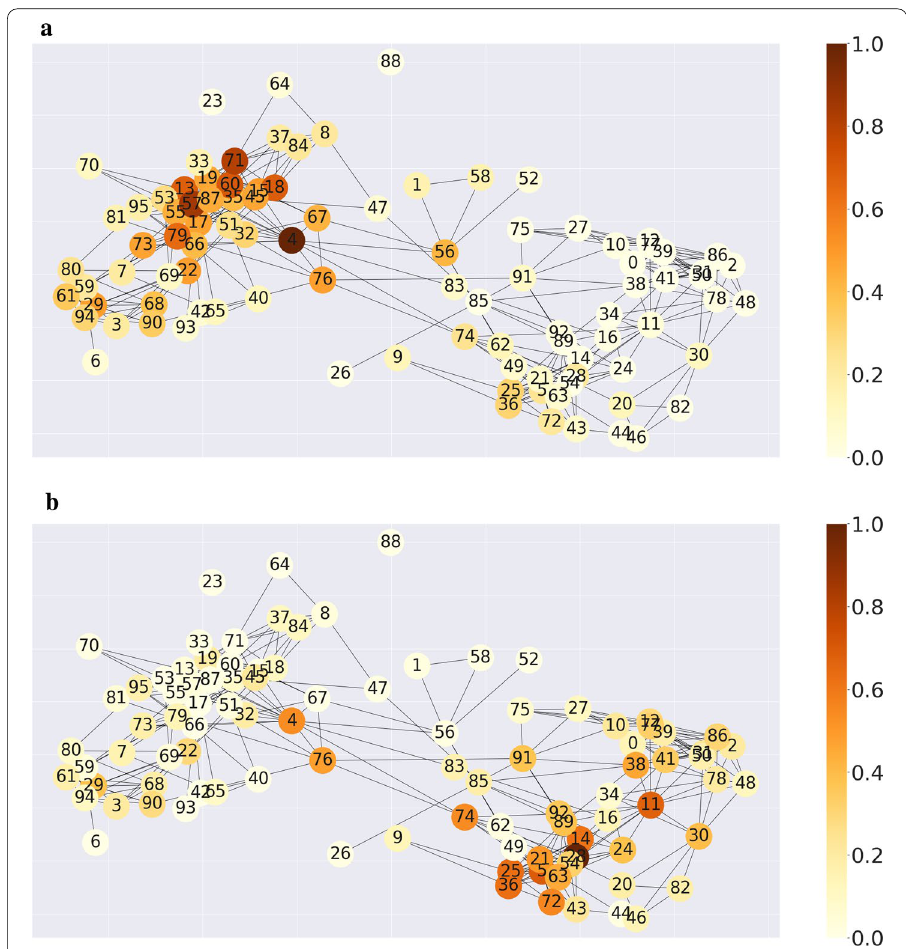
Fig. 10 The same interaction graph constructed with Pearson correlation coefficients for two different states detected using graphKKE . Vertices are colored according to the average number of edges: a period of cholera infection. b period of recovery. Brown color implies that particular species (vertices) have more association interactions than species (vertices) in